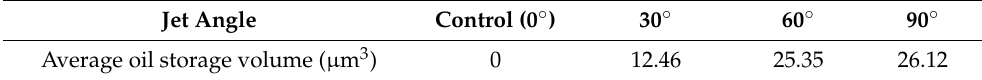
Table 3. The oil storage capacity of oil pockets at different jet angles of